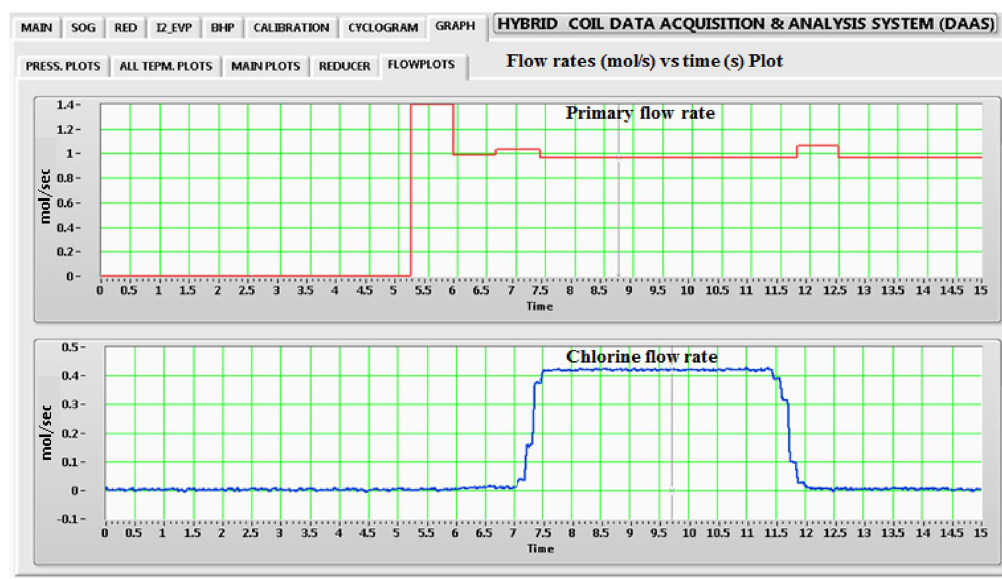
Figure 7. Temporal flow rate variation, flow rate (mol s −1 ) vs. time